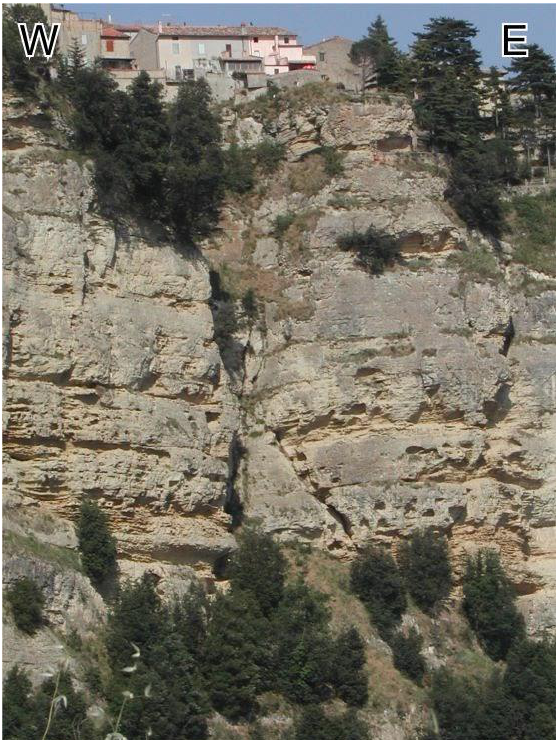
Figure 3. Open fractures and toppling phenomena affecting the arenaceous plate of Mount Falcone.